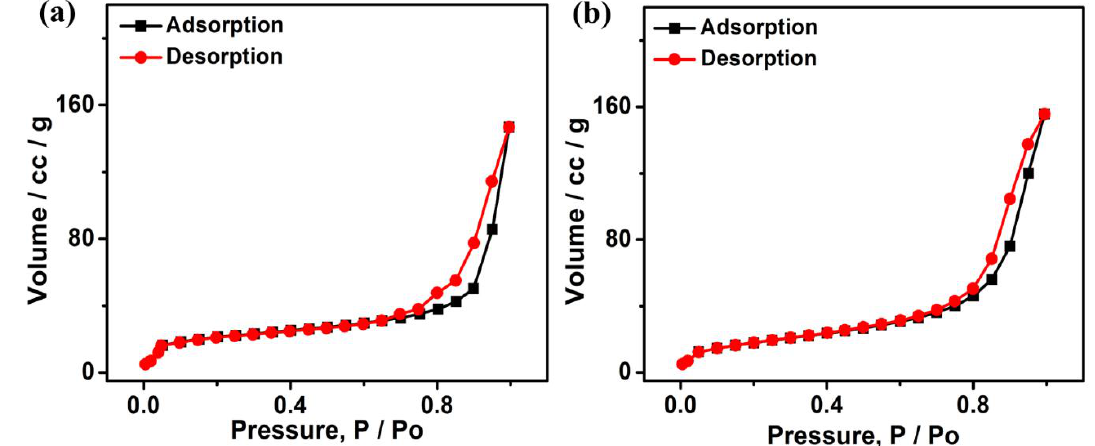
Figure 5. ( a ) N 2 adsorption-desorption isotherms of Pd/Cu/CN NWs and ( b ) CN NWs.